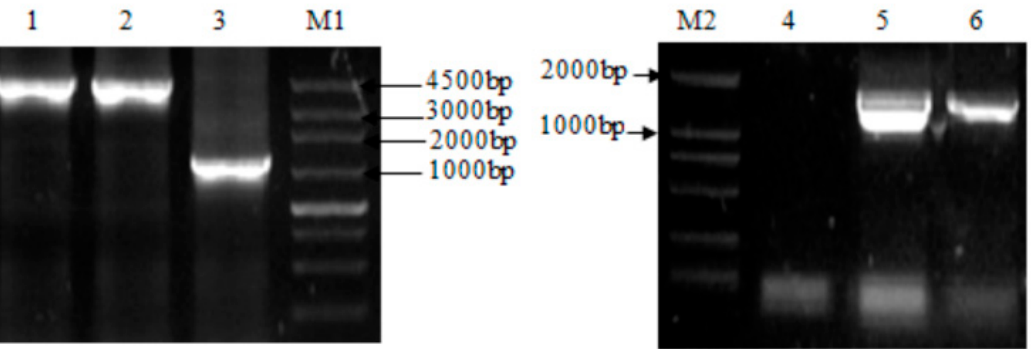
Figure 4. PCR amplification of wild-type strain and transformants. Two transformants, T1 (lanes 1 and 5) and T2 (lanes 2and 6), and wild-type strain (lanes 3 and 4) were firstly screened by PCR with specific primers P1and P2 (lanes 1–3) and then confirmed with primers P7 and P8 (lanes 4–6). M1: Marker 4500; M2: Marker 2000.